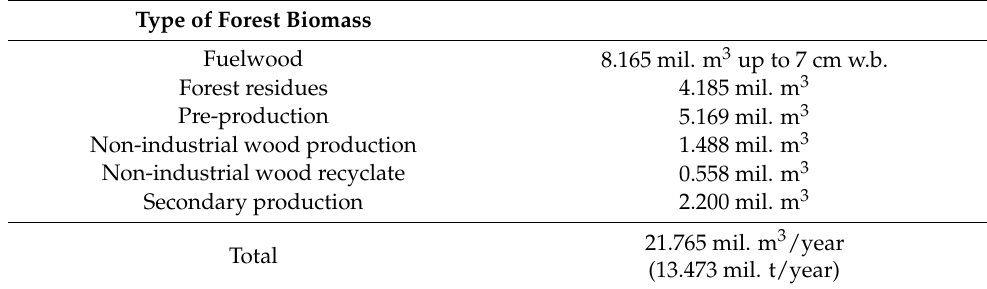
Table 3. Estimation of the total annual available volume of dendromass for energy production in the Czech Republic for the period extending up to